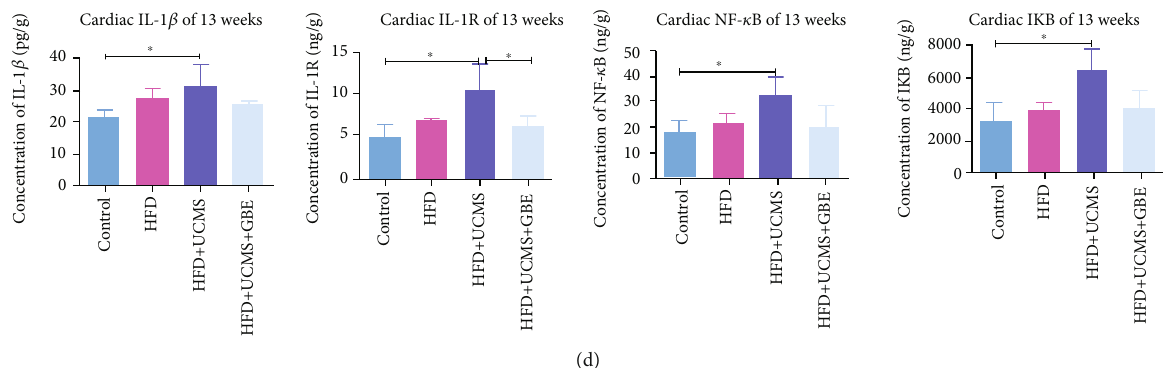
Figure 5: Cardiac function by echocardiography and in fl ammation by ELISA. (a, b) LVEF, LVFS, MVE, MVA, and MVE/A comparisons in di ff erent treatment groups in the 13 th week; (c) the level of hs-cTNI, NT-proBNP, and IMA comparisons in di ff erent treatment groups in the 13 th week; (d) comparisons of cardiac in fl ammatory cytokines by ELISA involving IL-1 β , IL-1R, NF- κ B, and I κ B; IMA: Ischemia-modi fi ed albumin; LVEF: left ventricular ejection fraction; LVFS: left ventricular fractional shortening; MV E: peak E wave of Mitral valve; MV A: peak A wave of Mitral valve; n = 5 per group; ∗ P < 0 : 05 ; ∗∗ P < 0 : 01 ; ∗∗∗ P < 0 : 001 .